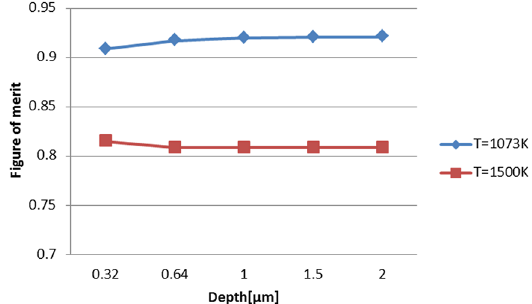
Figure 8. Figure of merit for increasing depth at temperatures T=1073K or